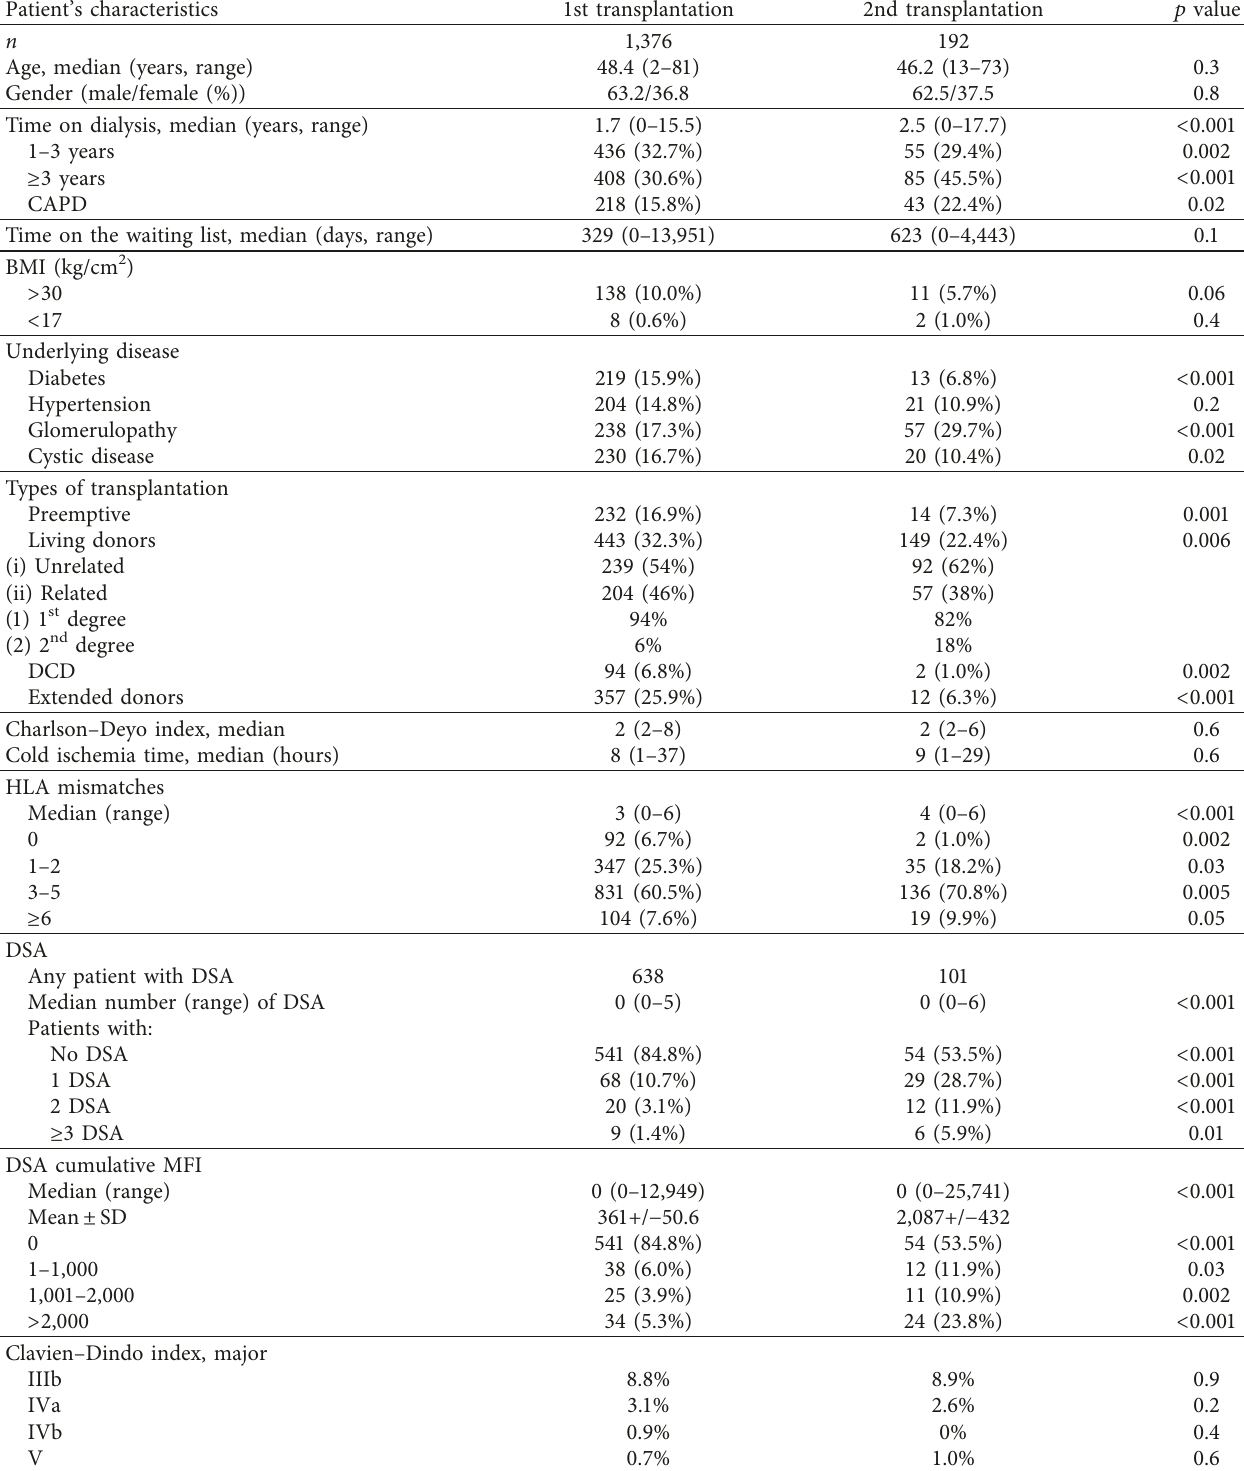
Table 1: Patient characteristics and surgical